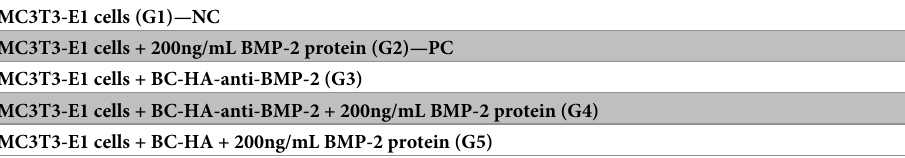
Table 1. Materials evaluated in the Gene expression